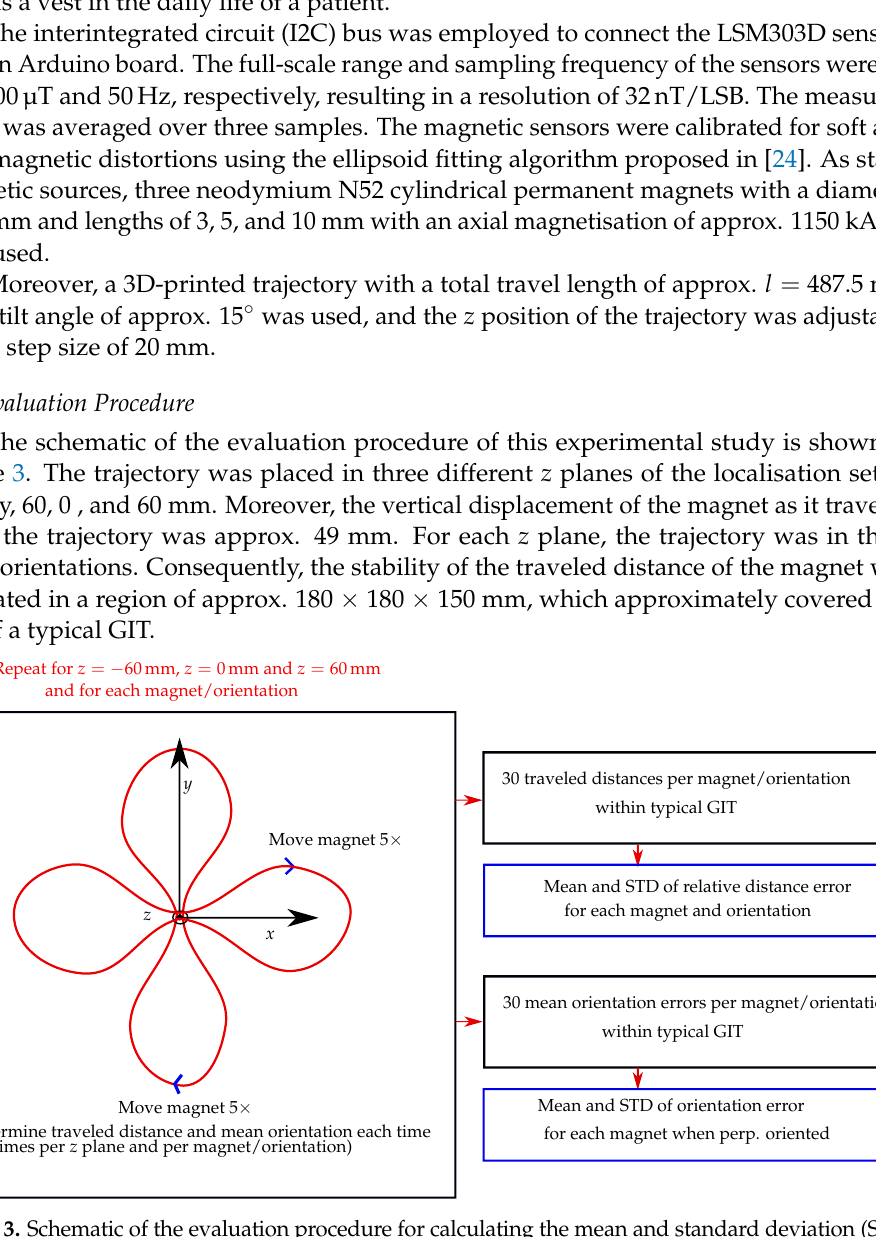
Figure 3. Schematic of the evaluation procedure for calculating the mean and standard deviation (STD) of the relative distance error and orientation error for each magnet, and its corresponding